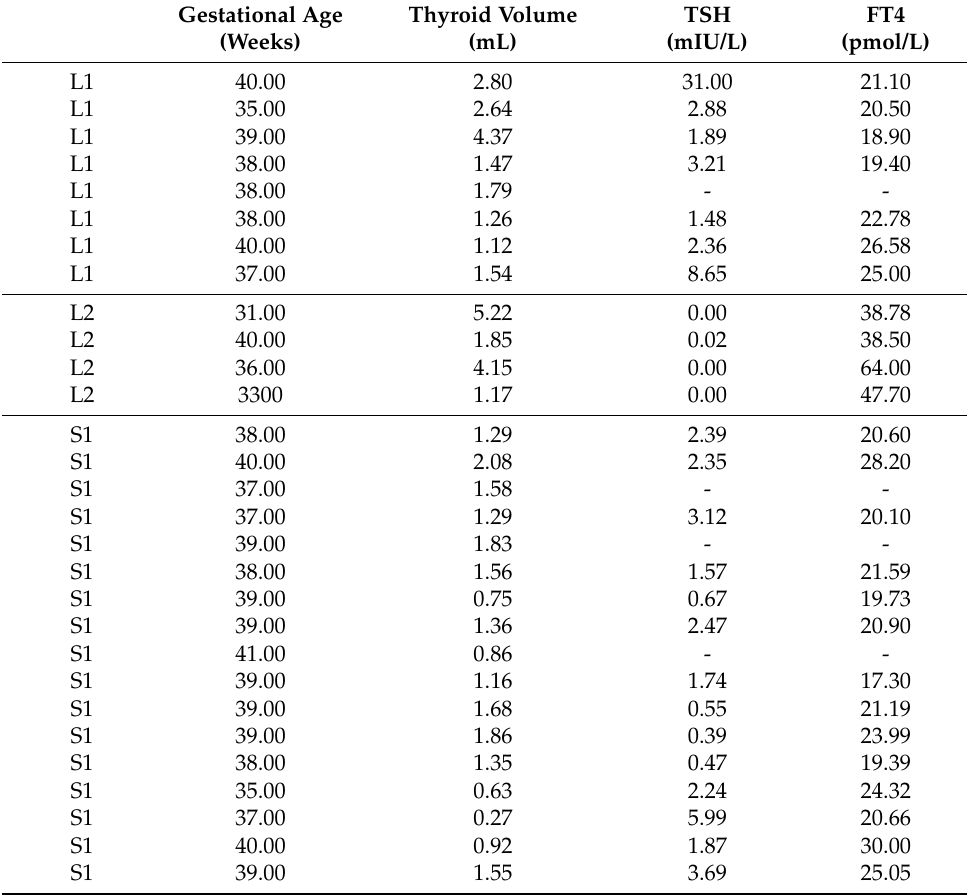
Table 3. Thyroid parameters between groups.